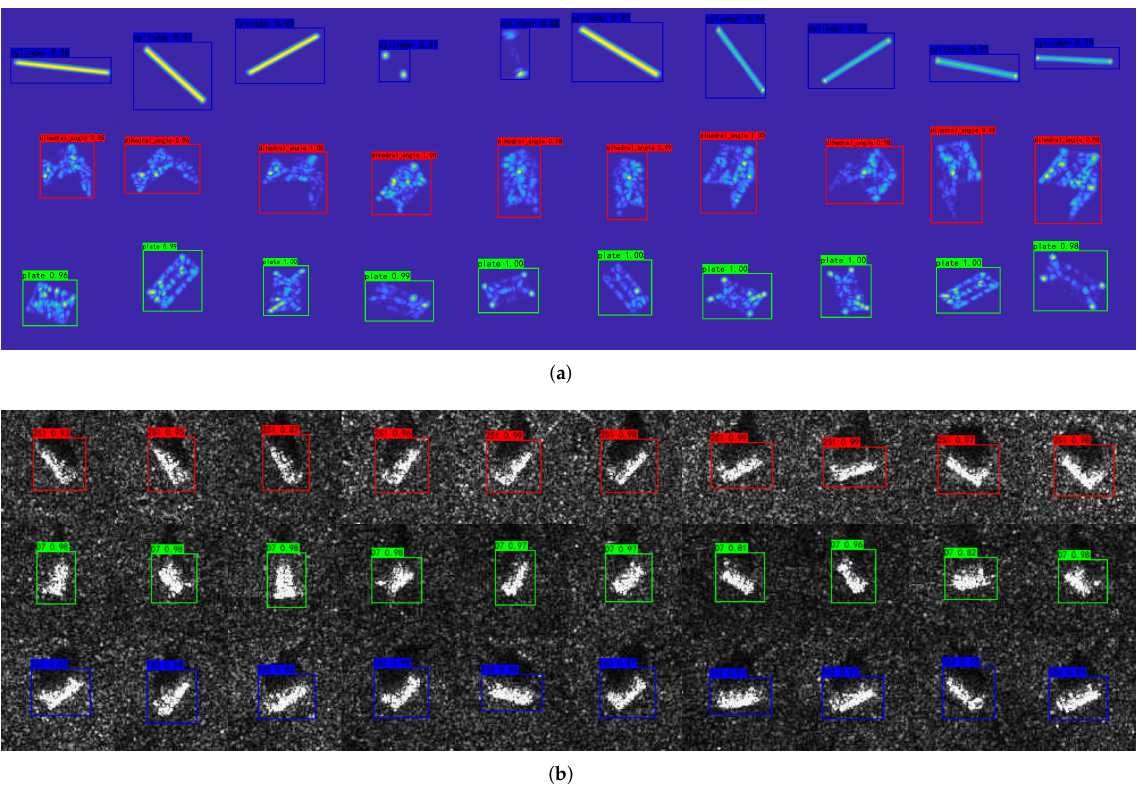
Figure 7. Detection results of improved SSD. ( a ) Part of GO dataset test results, ( b ) part of MSTAR dataset test